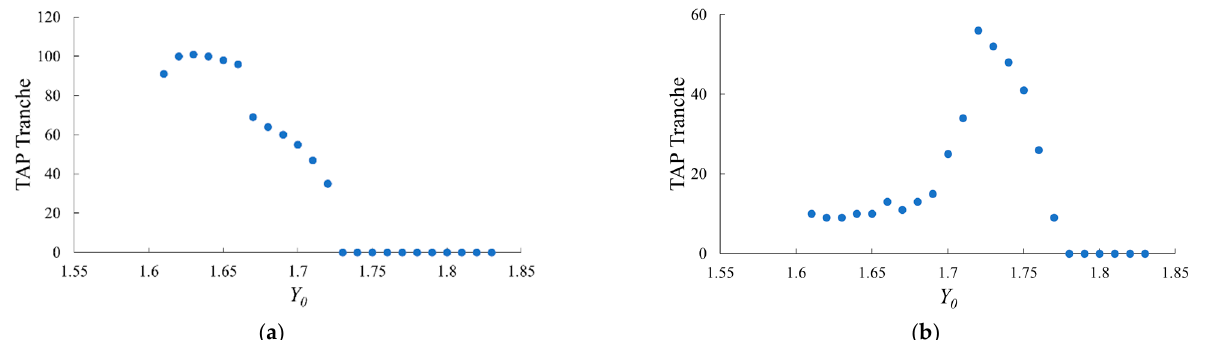
Figure 7. The plot for the largest time interval for each Y 0 value in AIII which when power shifted to Y ps = 1.84 ( a ) or Y PS = 1.96 ( b ) takes the system to AV ( a ) or AVI ( b ), respectively. Y 0 = 1.63 has the largest tranche for Y PS = 1.84 . Y 0 = 1.72 has the largest tranche for Y PS = 1.96 .